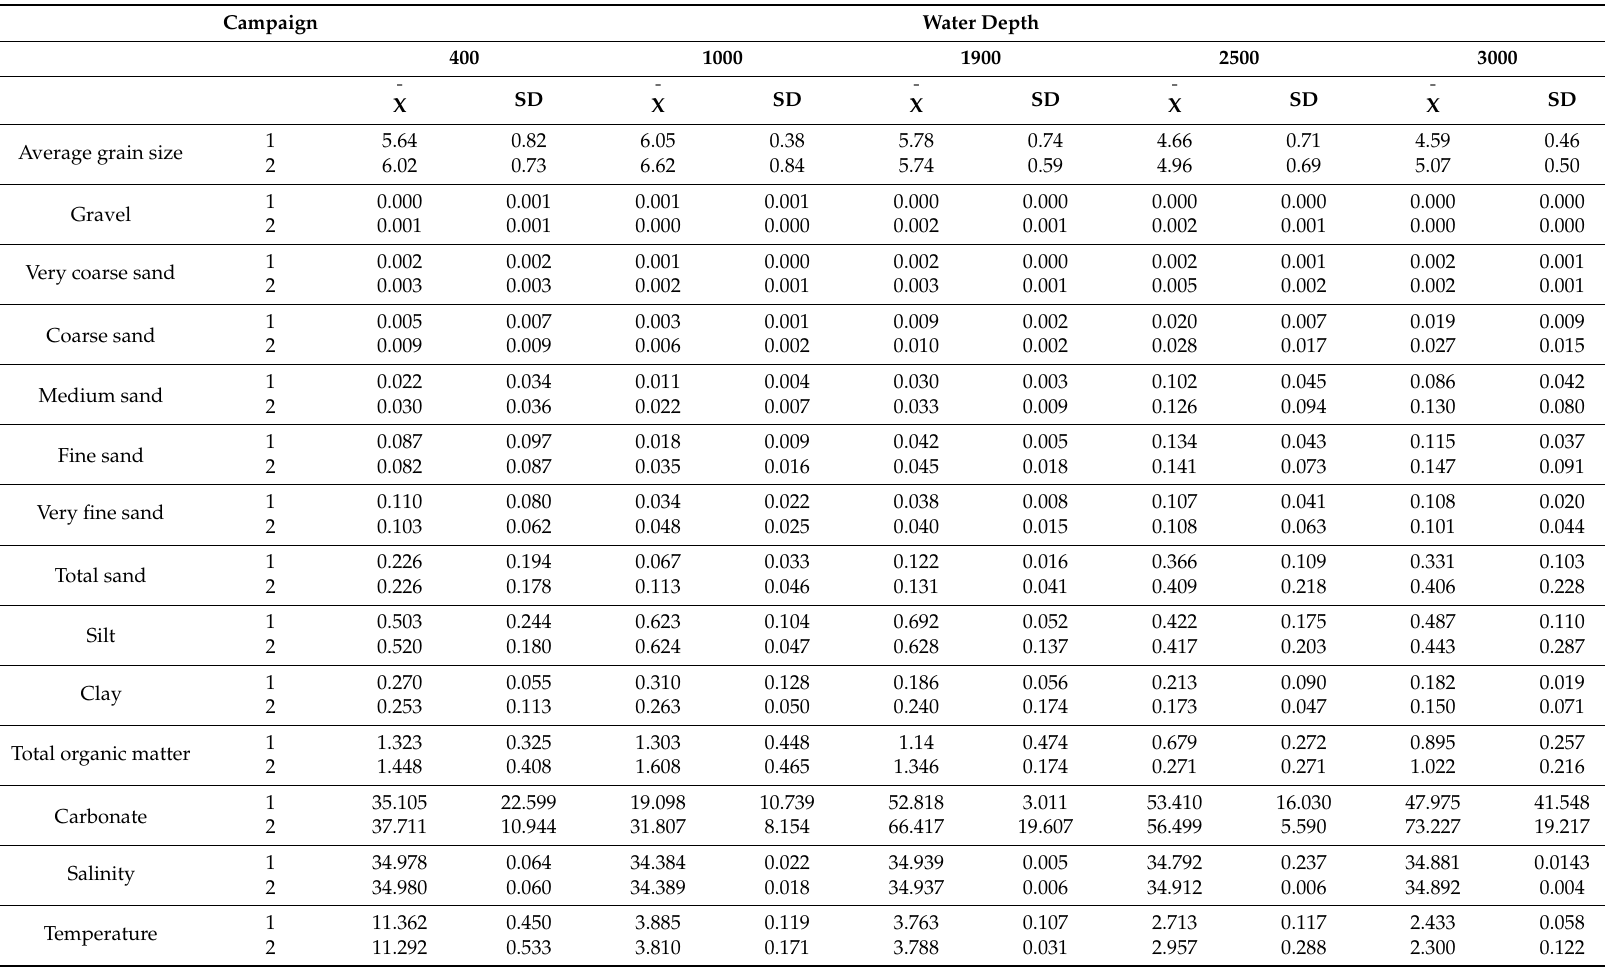
¯ Table 1. Mean ( X ) and standard deviation (SD) values of environmental variables (types of sand: very coarse, coarse, medium, fine, very fine (%), average grain size (Phi), silt (%), gravel (%), clay (%), temperature ( ◦ C), carbonate (%), and organic matter (%) found at depths of 400, 1000, 1900, 2500, and 3000